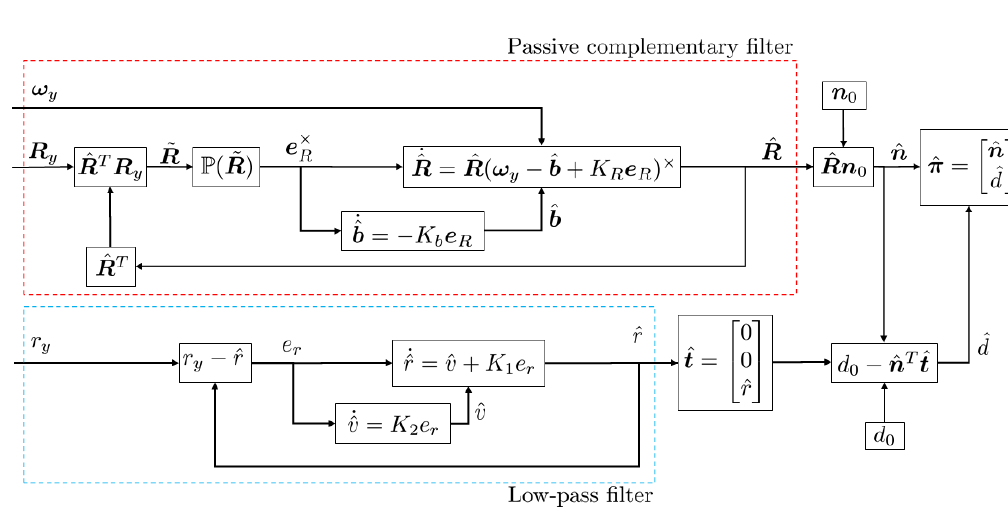
Figure 2: Block diagram of the passive complementary filter (in red) for the attitude estimation with bias correction, combined with the low pass filter (in blue) on the lidar measurements which provide the estimated